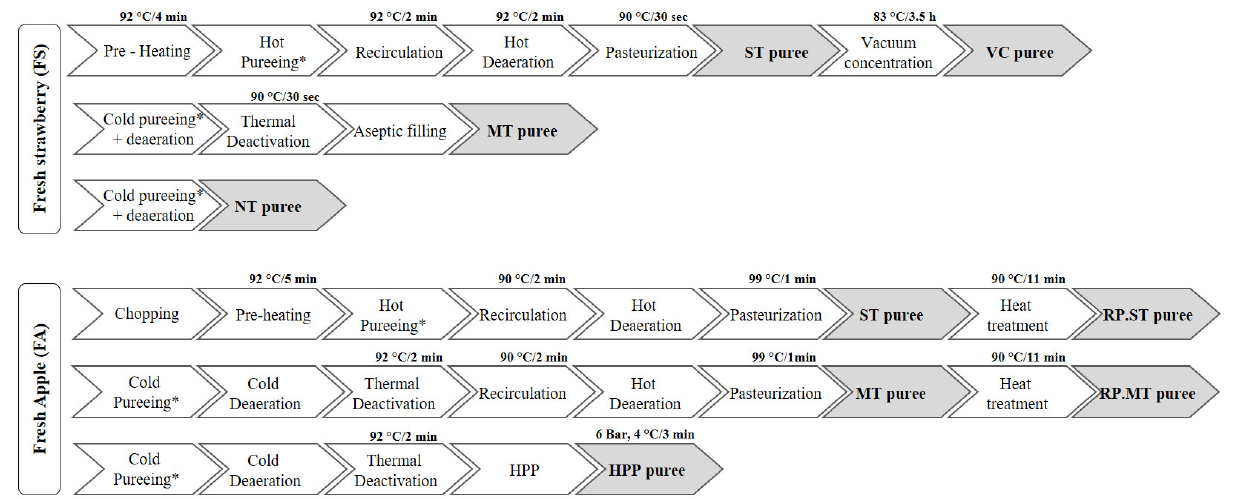
Figure 5. Diagram of the industrial processing techniques employed to obtain strawberry (Fresh strawberries (FS), No heat treatment (NT), mild heat treatment (MT), standard thermal treatment, vacuum concentration (VC)) and apple (Fresh apple (FA), High-pressure processing (HPP), mild heat treatment (MT), standard thermal treatment (ST), reprocessed mild heat treatment (RP.MT), reprocessed standard thermal treatment (RP.ST)) purees. * Removal of peel and seeds.